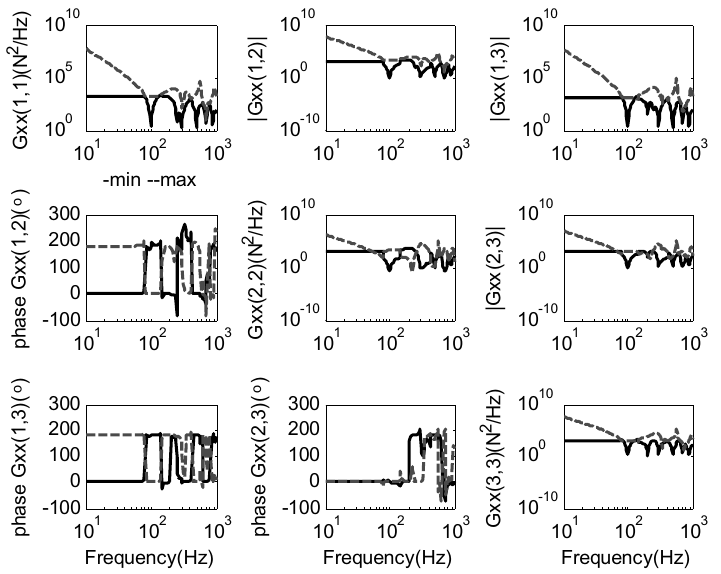
Fig. 9. Example 2, Input spectral density.